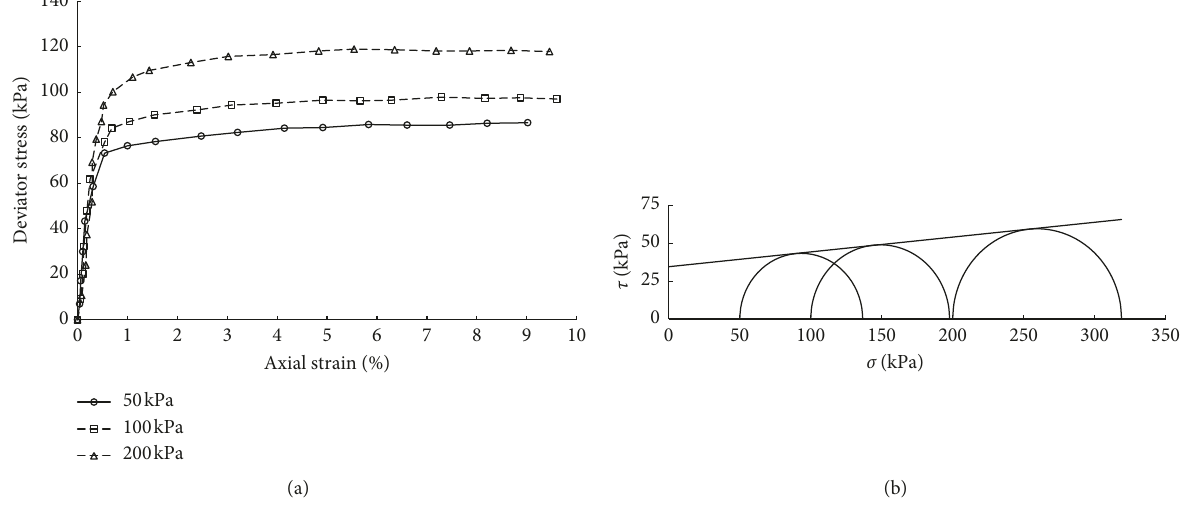
Figure 10: Results from the unconsolidated-undrained triaxial shear test: (a) stress-strain curves; (b) Mohr